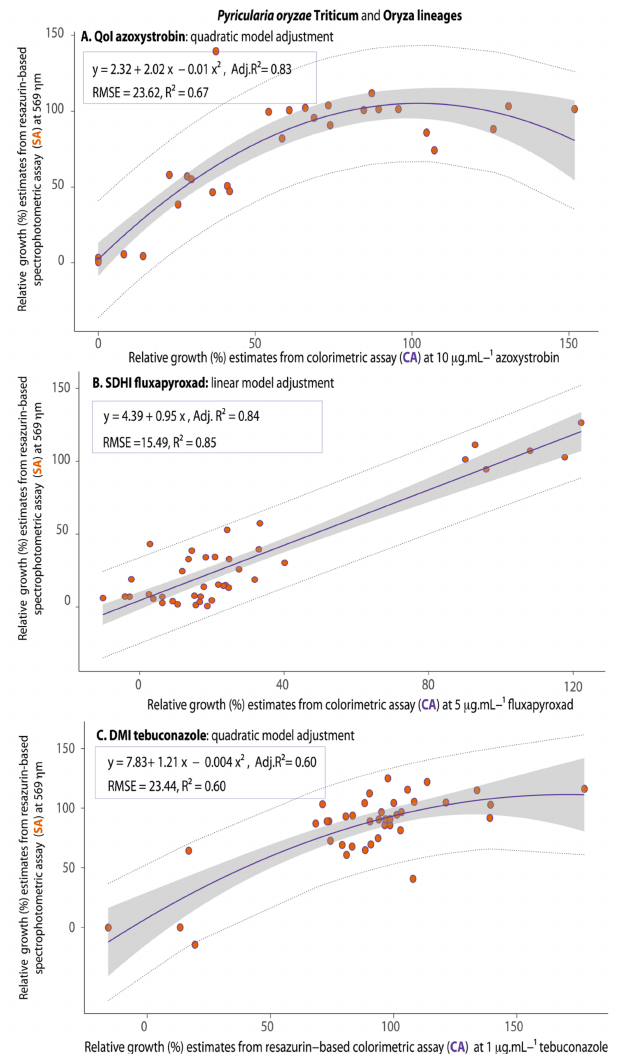
Figure 8. Regression models predicting the correspondence between the fungus relative growth estimates from the SPEC-assay at 569 nm (SA) on the basis of relative growth estimates from the COL-assay (CA) for QoI ( A ), SDHI ( B ), and DMI ( C ) fungicide sensitivity testing for Pyricularia oryzae Triticum lineage and P.oryzae Oryza lineage a,b . a The rectangle within each figure contains the corresponding linear equations, the adjusted R 2 (Adj. R 2 ) as a measure of precision of the colorimetric assay, and the model fit parameters ( RMSE and R 2 ). For the QoI ( A ) and DMI fungicide ( C ) the quadratic regression had the best fit as a predicting model while for SDHI ( B ) the linear regression had the best fit, with the lowest RMSE and the highest R 2 . b The regression lines were presented in purple, the confidence interval band of the prediction model in gray and the distribution of the values by orange circles contained within the limits of dotted